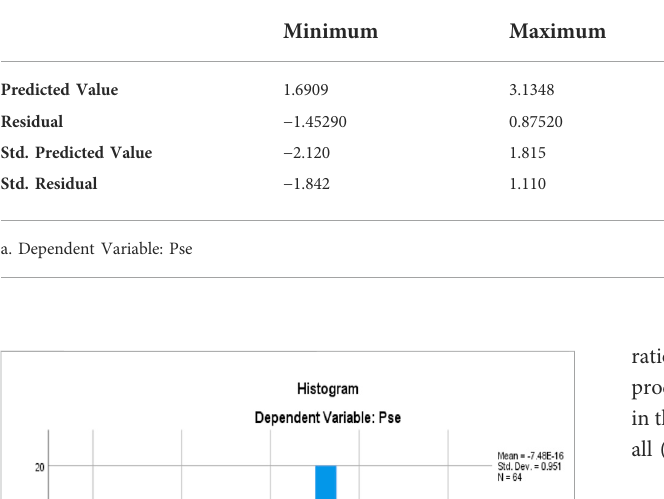
TABLE 19 Residuals statistics corresponding to the Pse dependent variable.